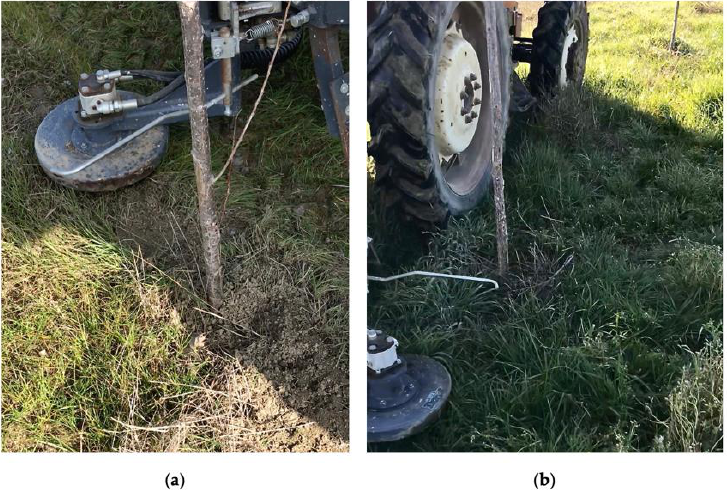
Figure 4. Mowing performed on 11 February 2022: ( a ) front view of the working mowing disc; ( b ) rear view of the working mowing disc.